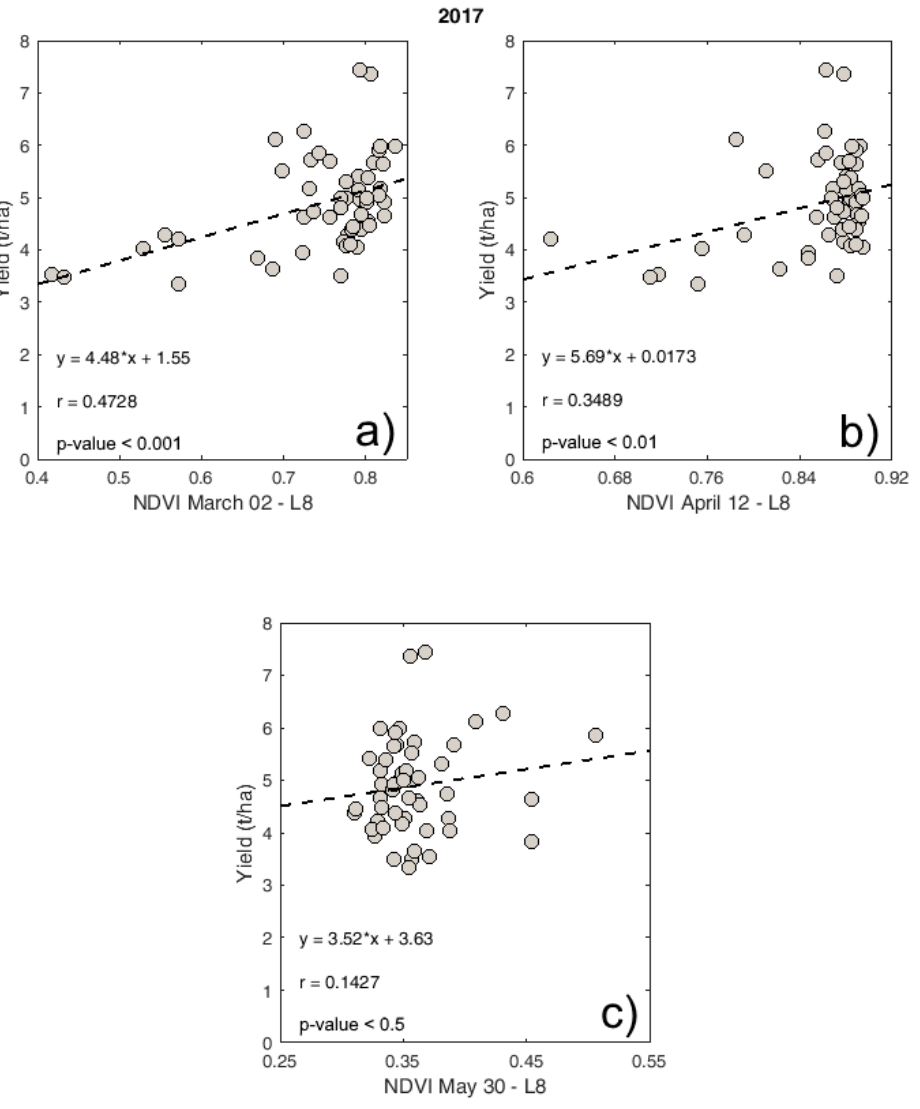
Figure 9. Relationship between observed yield (sampled) and NDVI (Landsat-8) for 2016–2017 crop season in ( a ) 2 March, ( b ) 12 April and ( c ) 30 May.